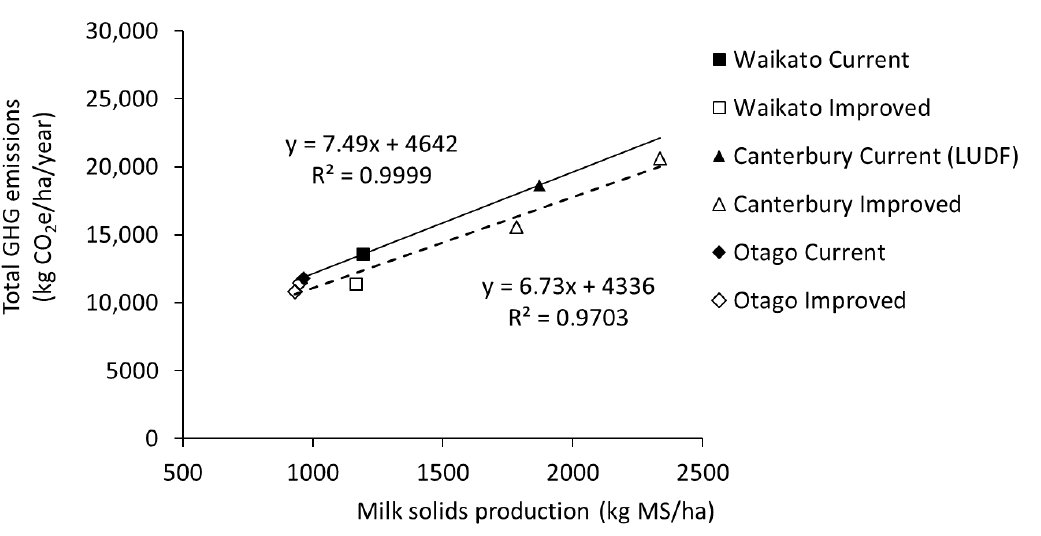
Figure 3. Relationship between milk production (kg MS/ha) and total GHG emissions for ‘current’ and ‘improved’ systems trialled in three regions of New Zealand. Also included is the Canterbury ‘current’ system based on an updated analysis of the Lincoln University Dairy Farm (LUDF) system (P. Beukes pers. comm.). There was no significant difference in the regression models.